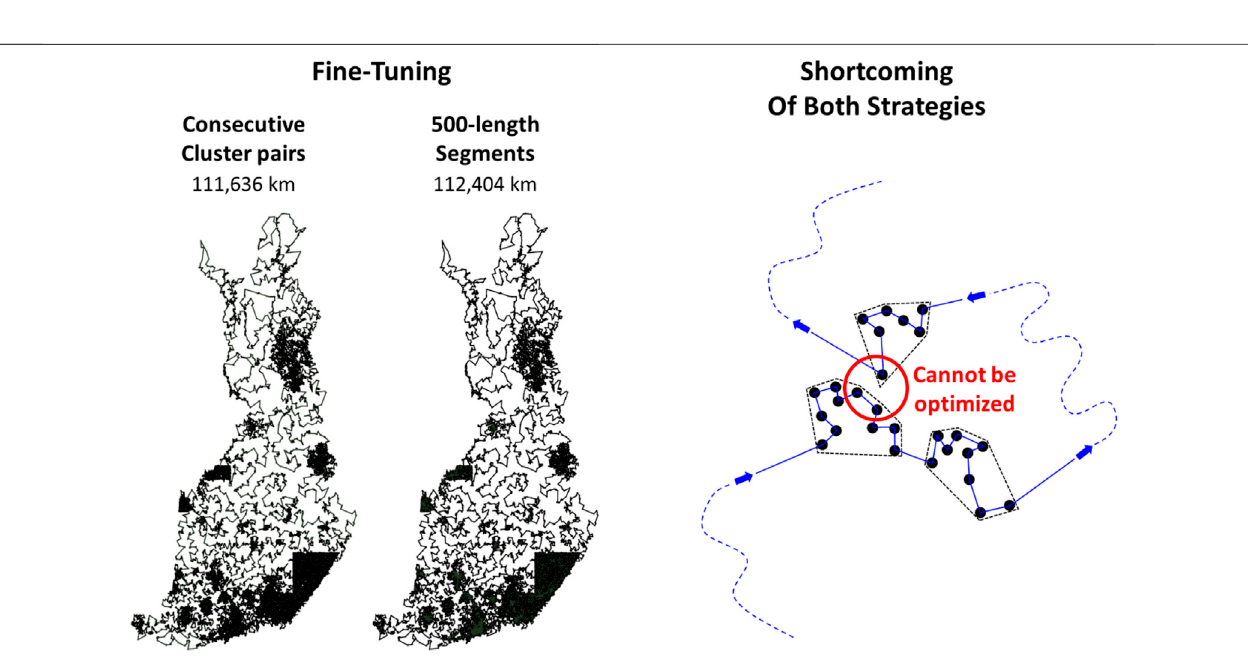
Frontiers in Robotics and AI |